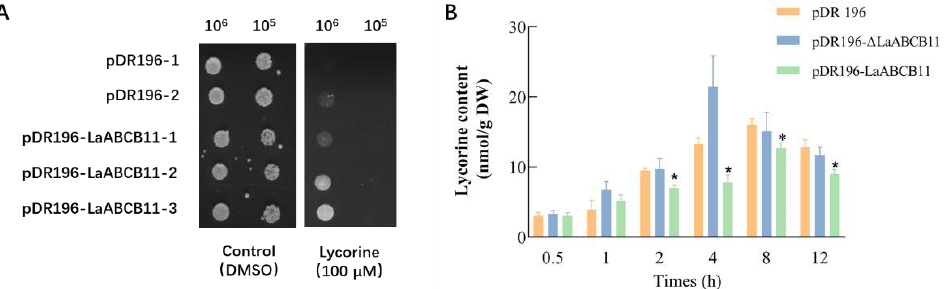
Figure 2. Lycorine sensitivity and export assays in yeast cells transformed with LaABCB11. ( A ) yeast mutant AD12345678 transformed with pDR196 (control) or pDR196-LaABCB11 were pre-cultured and diluted to OD 600 = 0.1 and 0.01. Five µ L of culture was dropped onto solid SD medium containing 100 µ M lycorine and incubated at 28 ◦ C for 2 days. ( B ) Yeast cells expressing pDR196 (control), pDR196-LaABCB11 or pDR196- ∆ LaABCB11 (mutant of LaABCB11), were incubated in SD medium with 0.3 mM lycorine for 0.5–12 h. The error bars represent standard deviation from three biological replicates, and * indicates significant difference determined by one-way ANOVA ( p < 0.05), compared with vector control.